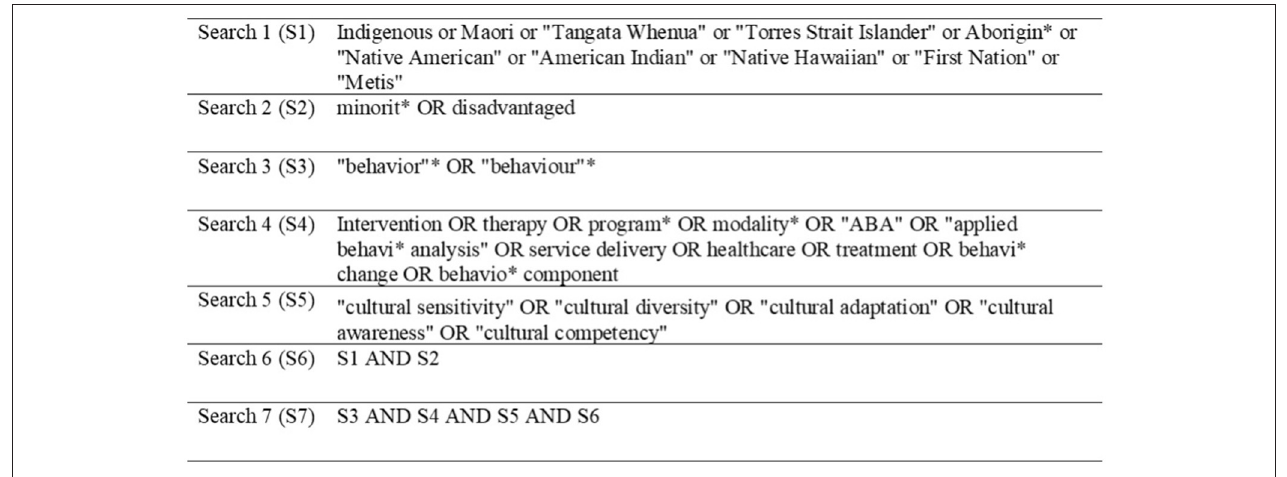
FIGURE 1 | Search